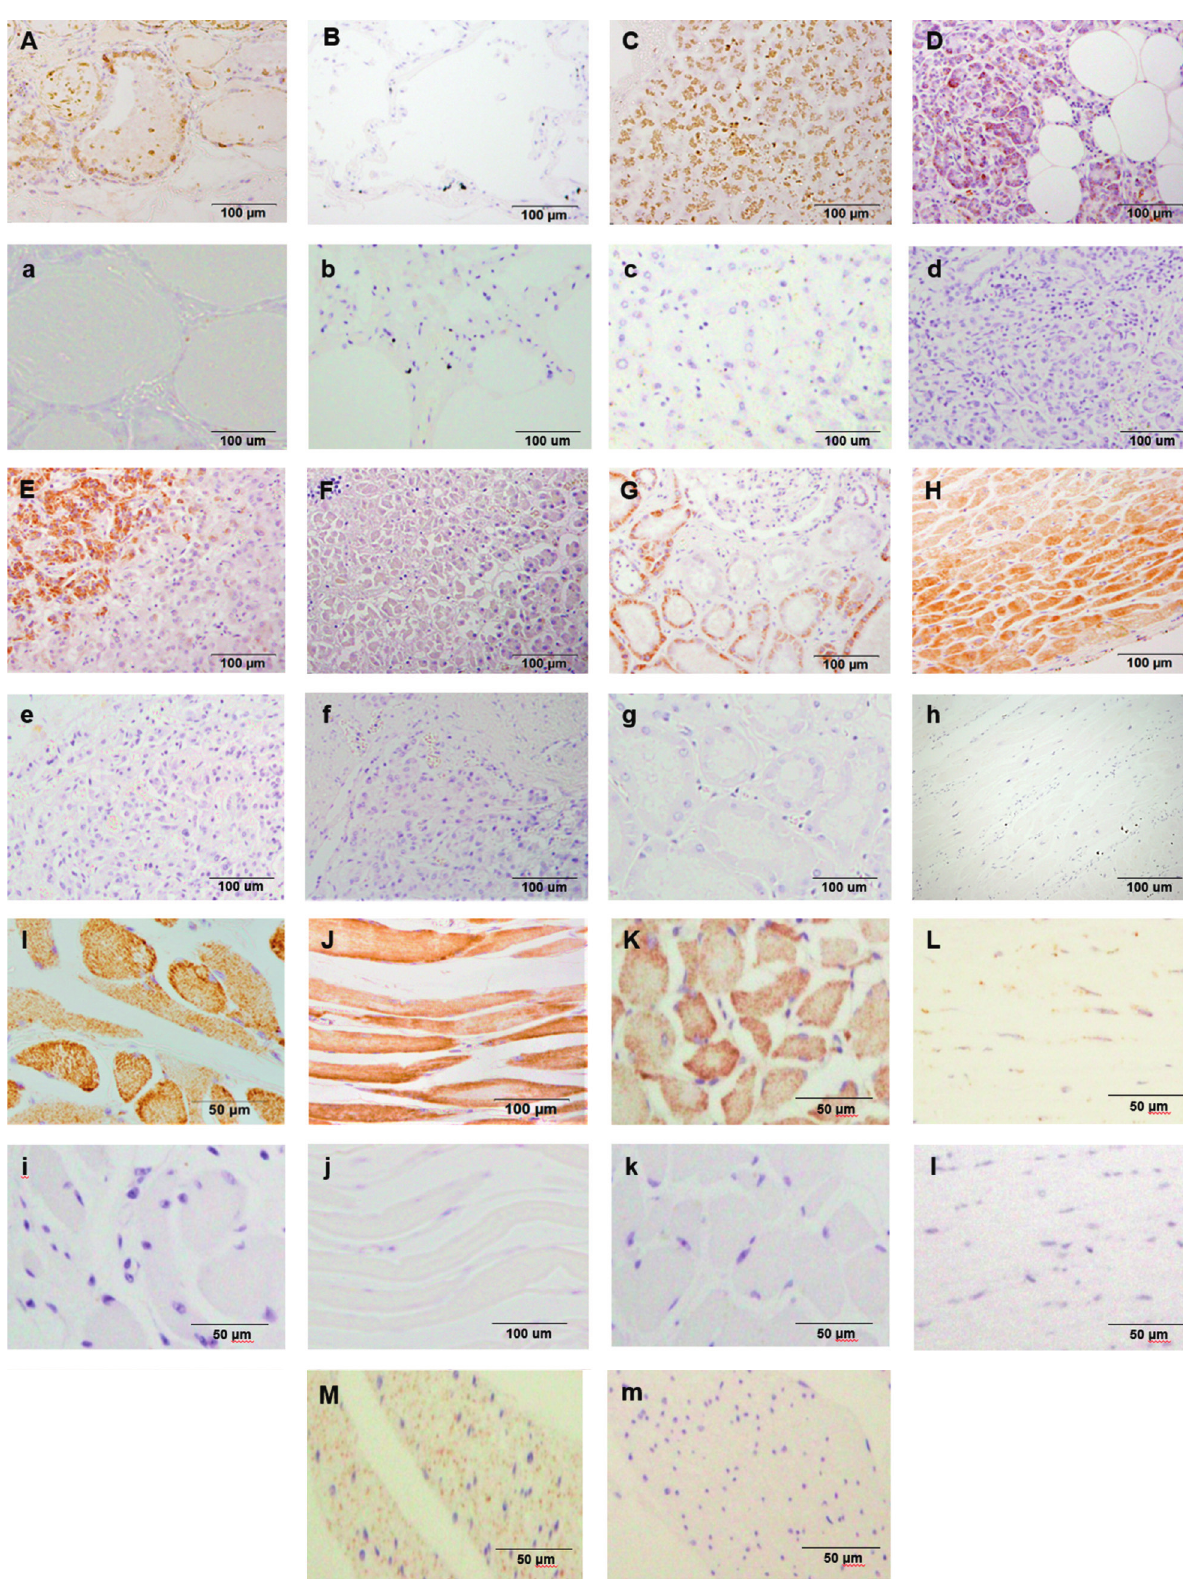
Figure 1: (Pro)renin receptor staining in organs outside the brain. (A) Thyroid gland; (B) lung; (C) liver; (D) pancreas; and (E) cortex of the adrenal gland. Cells in the zona glomerulosa are stained; (F) medulla of the adrenal gland; (G) kidney; (H) left ventricle; (I) lingual muscle; (J) diaphragm; (K) iliopsoas muscle; (L), aorta; and (M) colon. (a–m) Negative controls in the organs